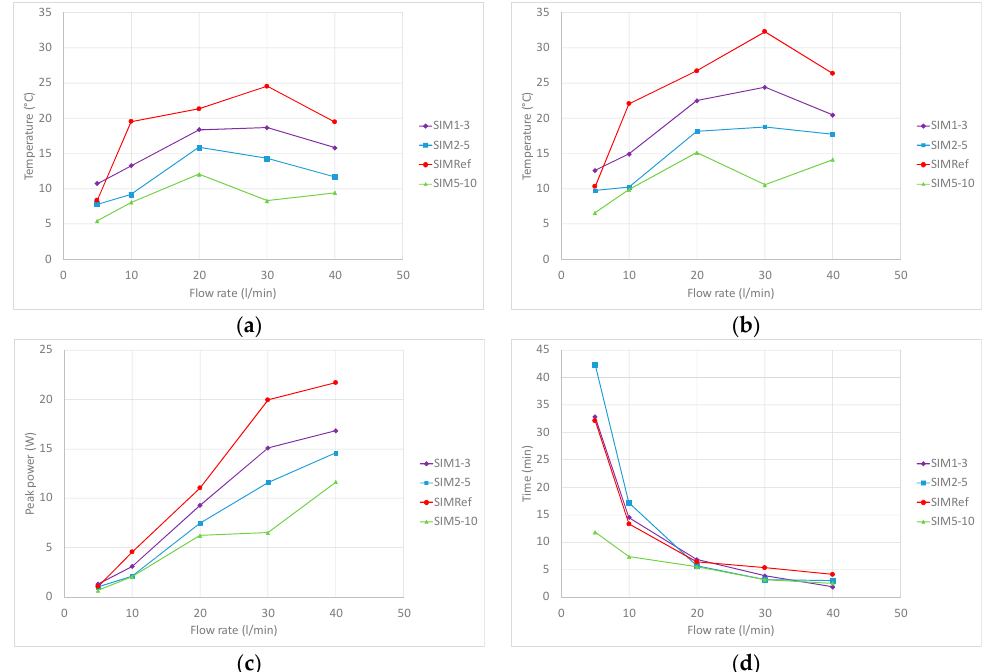
Figure 9. Performance of each particle size distribution over a 45-min period at each flowrate showing ( a ) mean outlet temperature uplift; ( b ) peak outlet temperature uplifts; ( c ) peak power and ( d ) time to peak power.